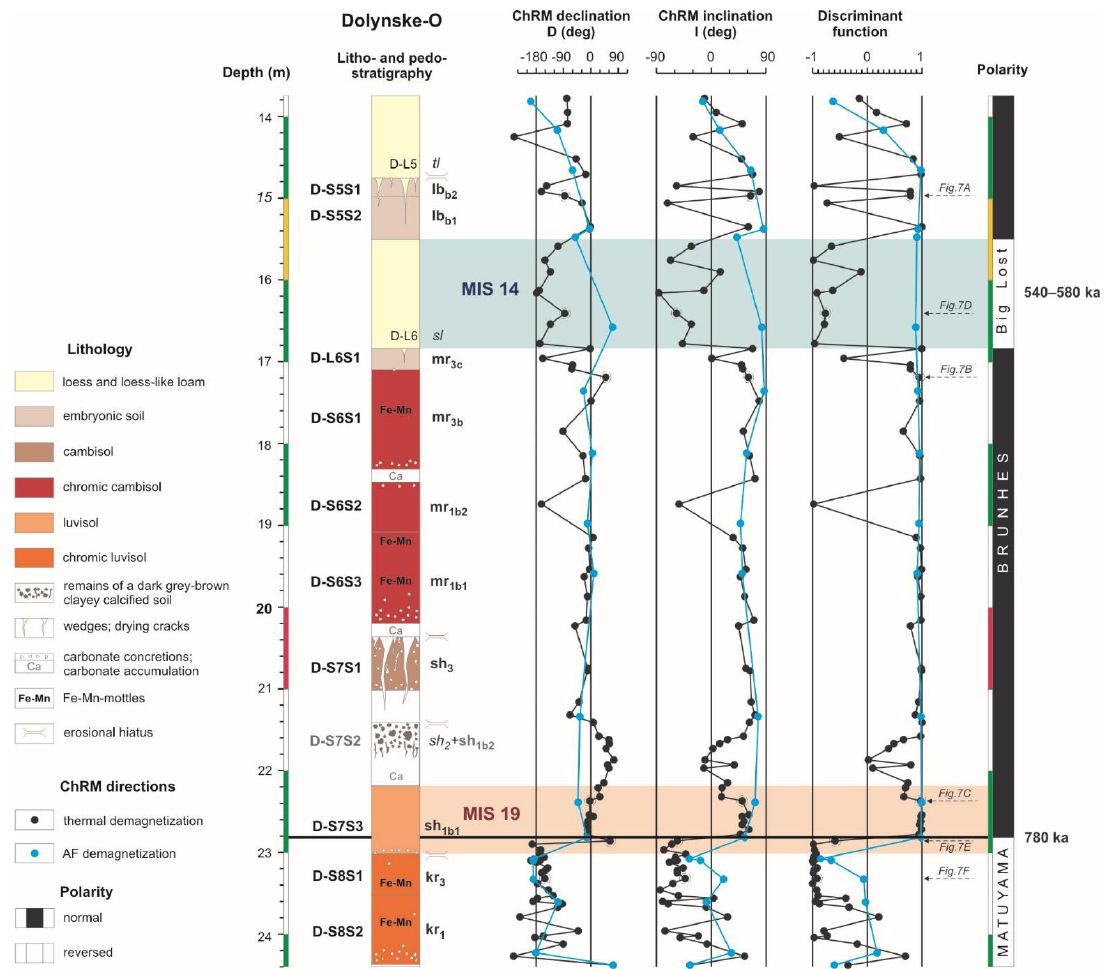
Figure 6. Results of palaeomagnetic study of the Dolynske-O subprofile. From the left — simplified lithostratigraphy, the directions of the ChRM components (expressed by declination D° and inclination I°), the discriminant function of these directions as a function of depth, and magnetostratigraphic chart. The arrows indicate the position of specimens for which the Zijderveld diagrams are shown in Figure 7.